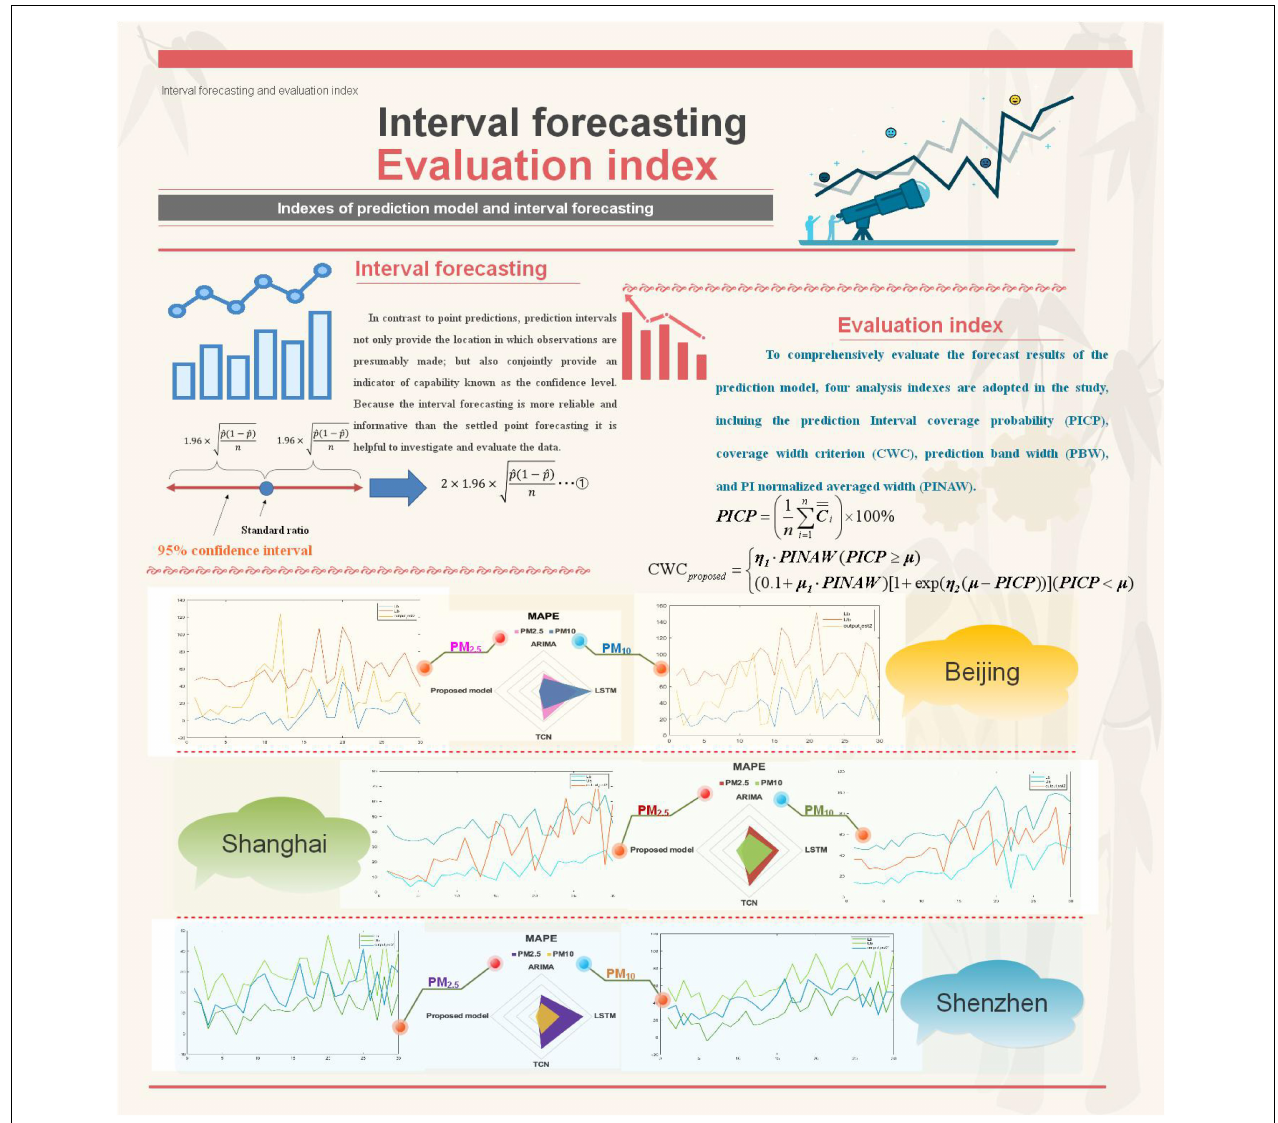
FIGURE 4 | A graph of interval prediction